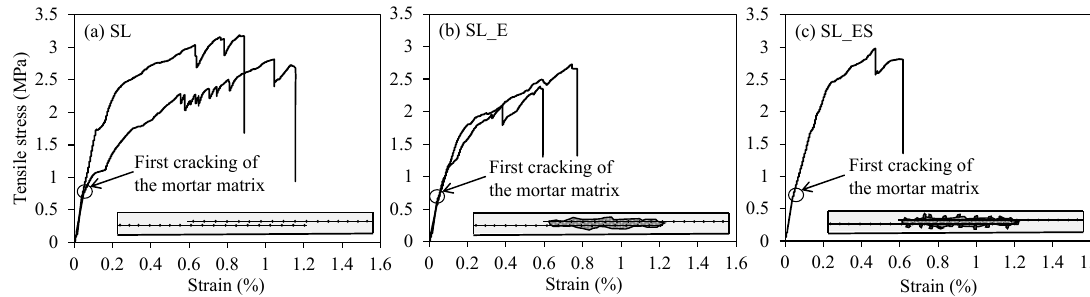
Figure 18. Tensile stress–strain relationship of TRM coupons with different surface treatments subjected to sustained load: ( a ) coupons without surface treatment; ( b ) coupons impregnated by epoxy; ( c ) coupons coated with aluminum oxide powder after epoxy impregnation.